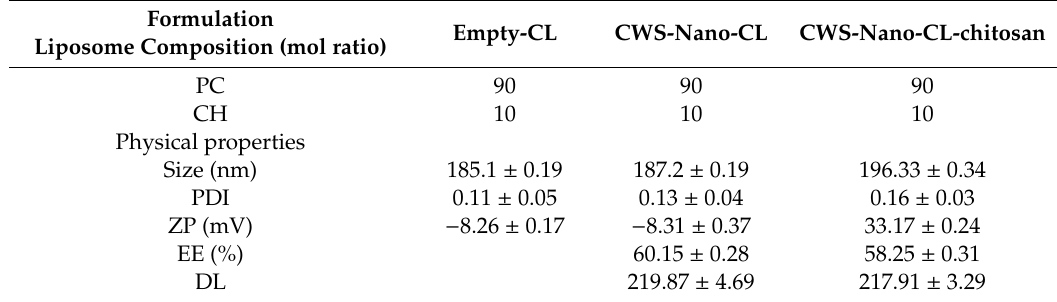
Table 1. Composition and physical properties of the prepared